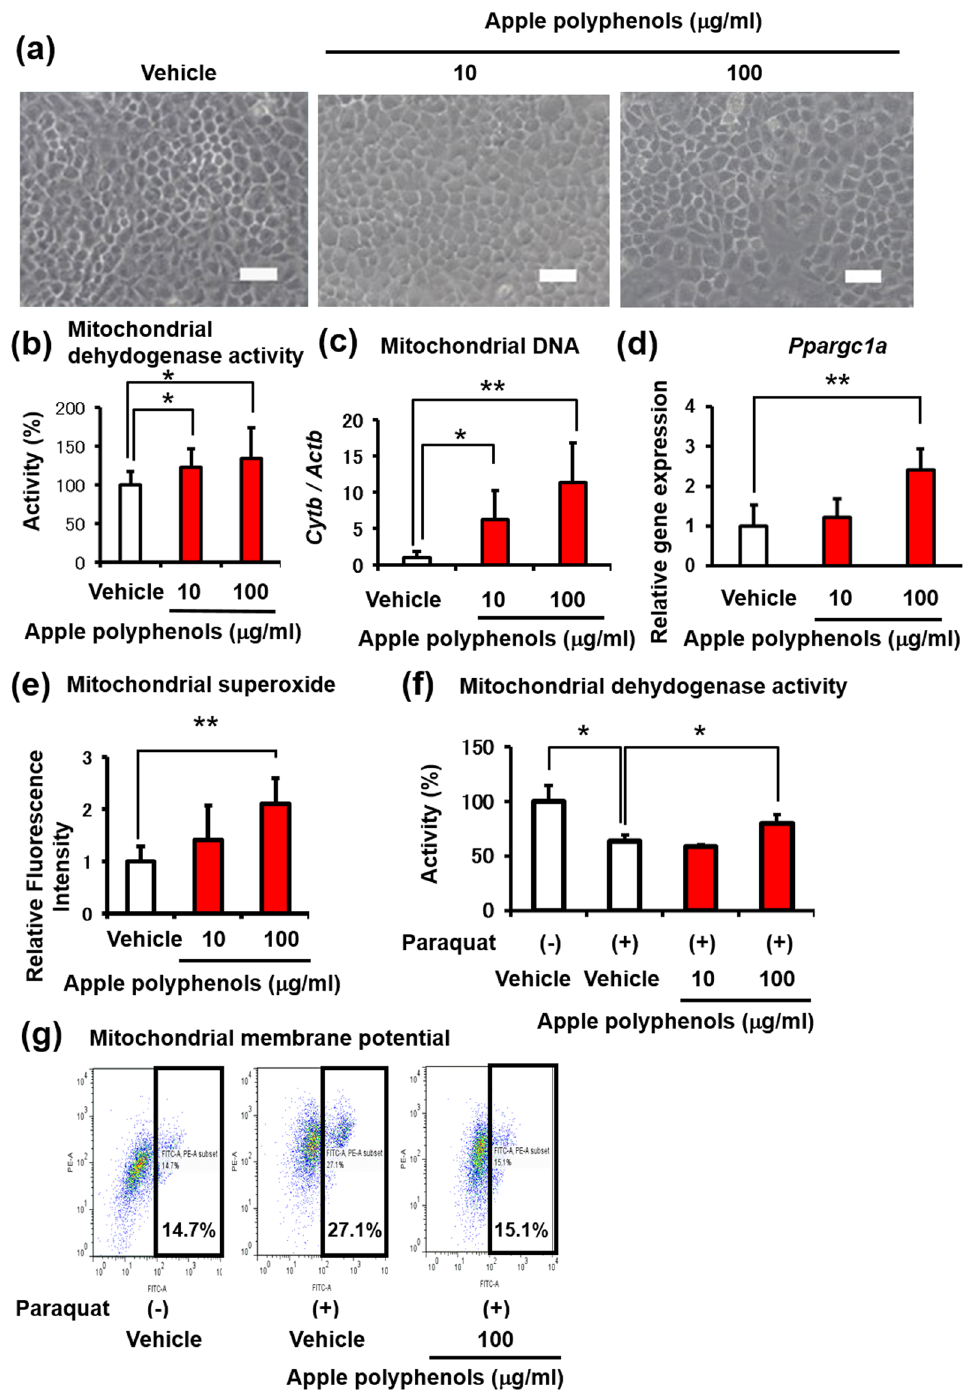
Figure 1. Apple polyphenols promote mitochondrial activity via mitochondrial biogenesis in primary chondrocytes. Apple polyphenols were added to primary chondrocytes or ATDC5 cells for 24 h. ( a ) Microscope images. Scale bars represent 100 µ m. ( b ) Mitochondrial dehydrogenase activity (n = 9–10), ( c ) mitochondrial DNA level (n = 6), ( d ) gene expression of PGC-1 α in ATDC5 cells (n = 6), ( e ) mitochondrial superoxide (n = 4–5). Primary chondrocytes were treated with apple polyphenols and paraquat. ( f ) Mitochondrial dehydrogenase activity (n = 3), ( g ) mitochondrial membrane potential ( ΔΨ m). High: the region of cells with normal ΔΨ m, Low: the region of cells with mitochondrial depolarization. Values are the mean ± standard deviation ( * P < 0.05, ** P < 0.01, versus control, Student’s t